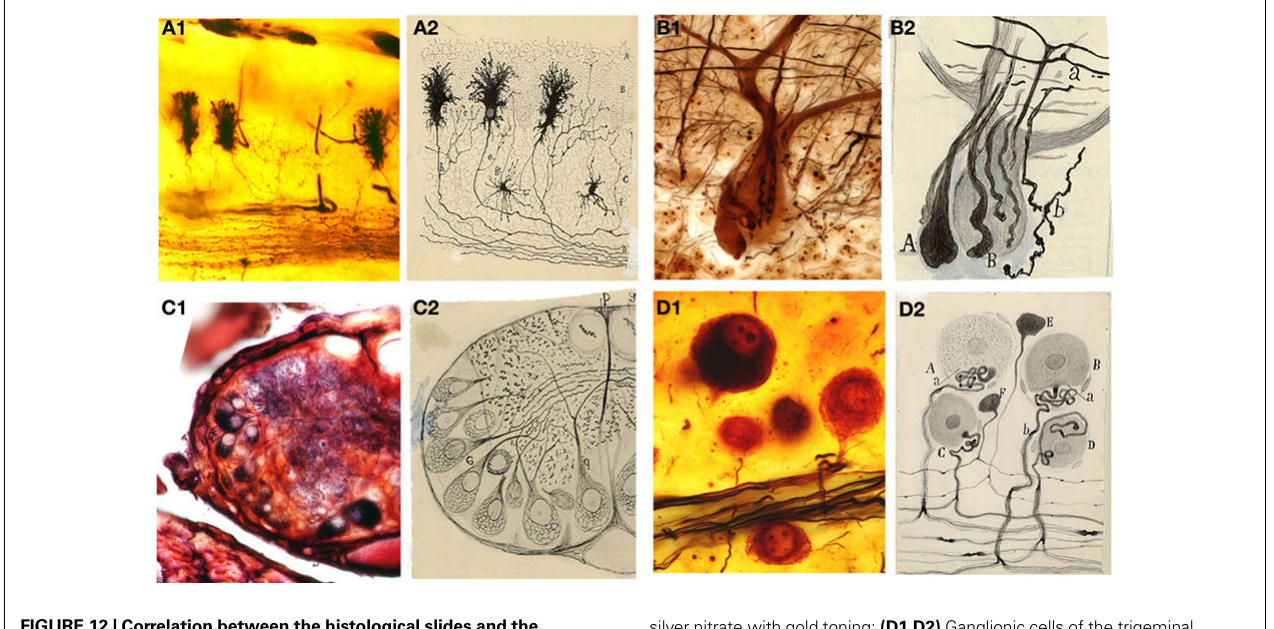
silver nitrate with gold toning; (D1,D2) Ganglionic cells of the trigeminal nucleus of the mouse, reduced silver nitrate method (Drawings reproduced with the permission of the Inheritors of Santiago Ramón y Cajal